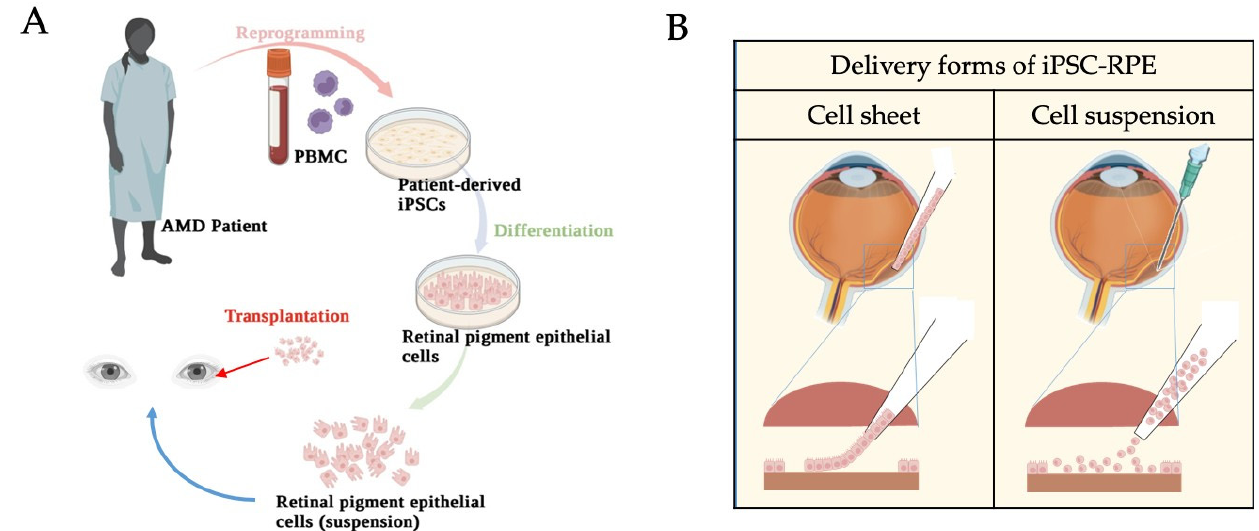
Figure 6. Schematic diagrams of iPSC-RPE transplantation. ( A ) Peripheral blood mononuclear cells (PBMCs) from the AMD patient were reprogrammed into iPSCs, followed by differentiation into iPSC-derived RPEs. The iPSC-derived RPE cells, as cell suspension, were transplanted back into the patient’s subretinal space. ( B ) Delivery forms of transplantation in the eye. (Image credit—Created with BioRender.com)